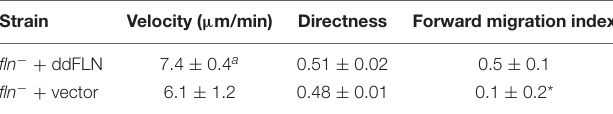
a Values are mean ± SE of three experiments with 50 cells analyzed and averaged for each experiment. Images were acquired every 10 s for 20 min while cells were continuously exposed to 6 dyn/cm 2 shear stress. Cells were tracked for the last 18 min for analysis. *P < 0.05 compared to fln − + ddFLN